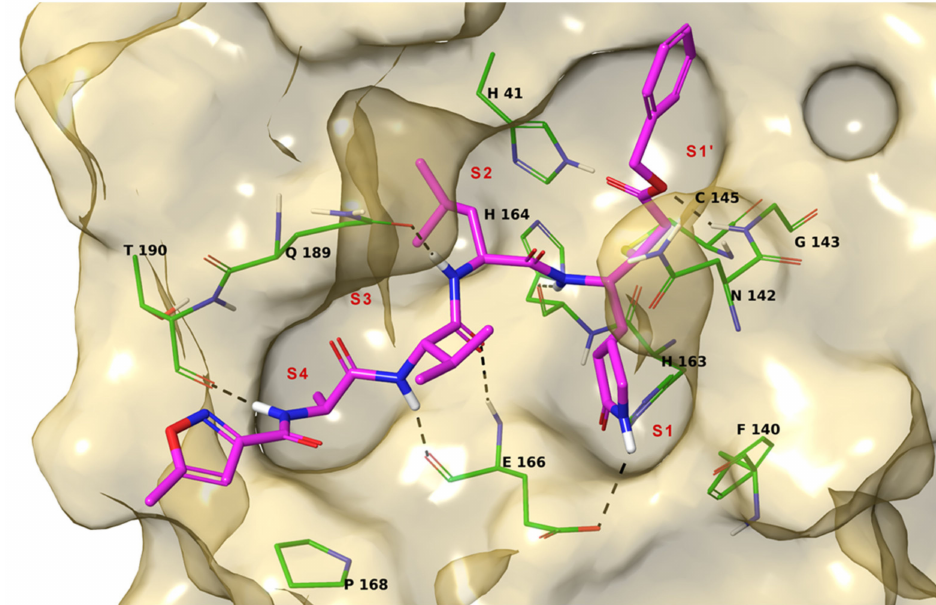
Figure 1. 3D model of the interaction between N3 and M pro . The protein is represented by gold molecular surface and green tubes (atom color code: C, as tubes; polar H, sky blue; N, dark blue; O, red; S, yellow). N3 is depicted by magenta tubes (atom color code as for protein). The protein sub-pockets are indicated by red labels. The black dashed lines indicate ligand-protein